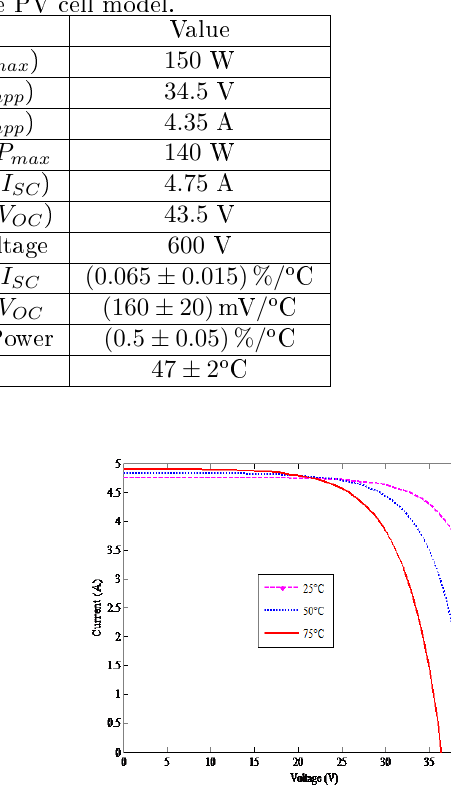
Fig. 4: I-V characteristics under variable temperature.